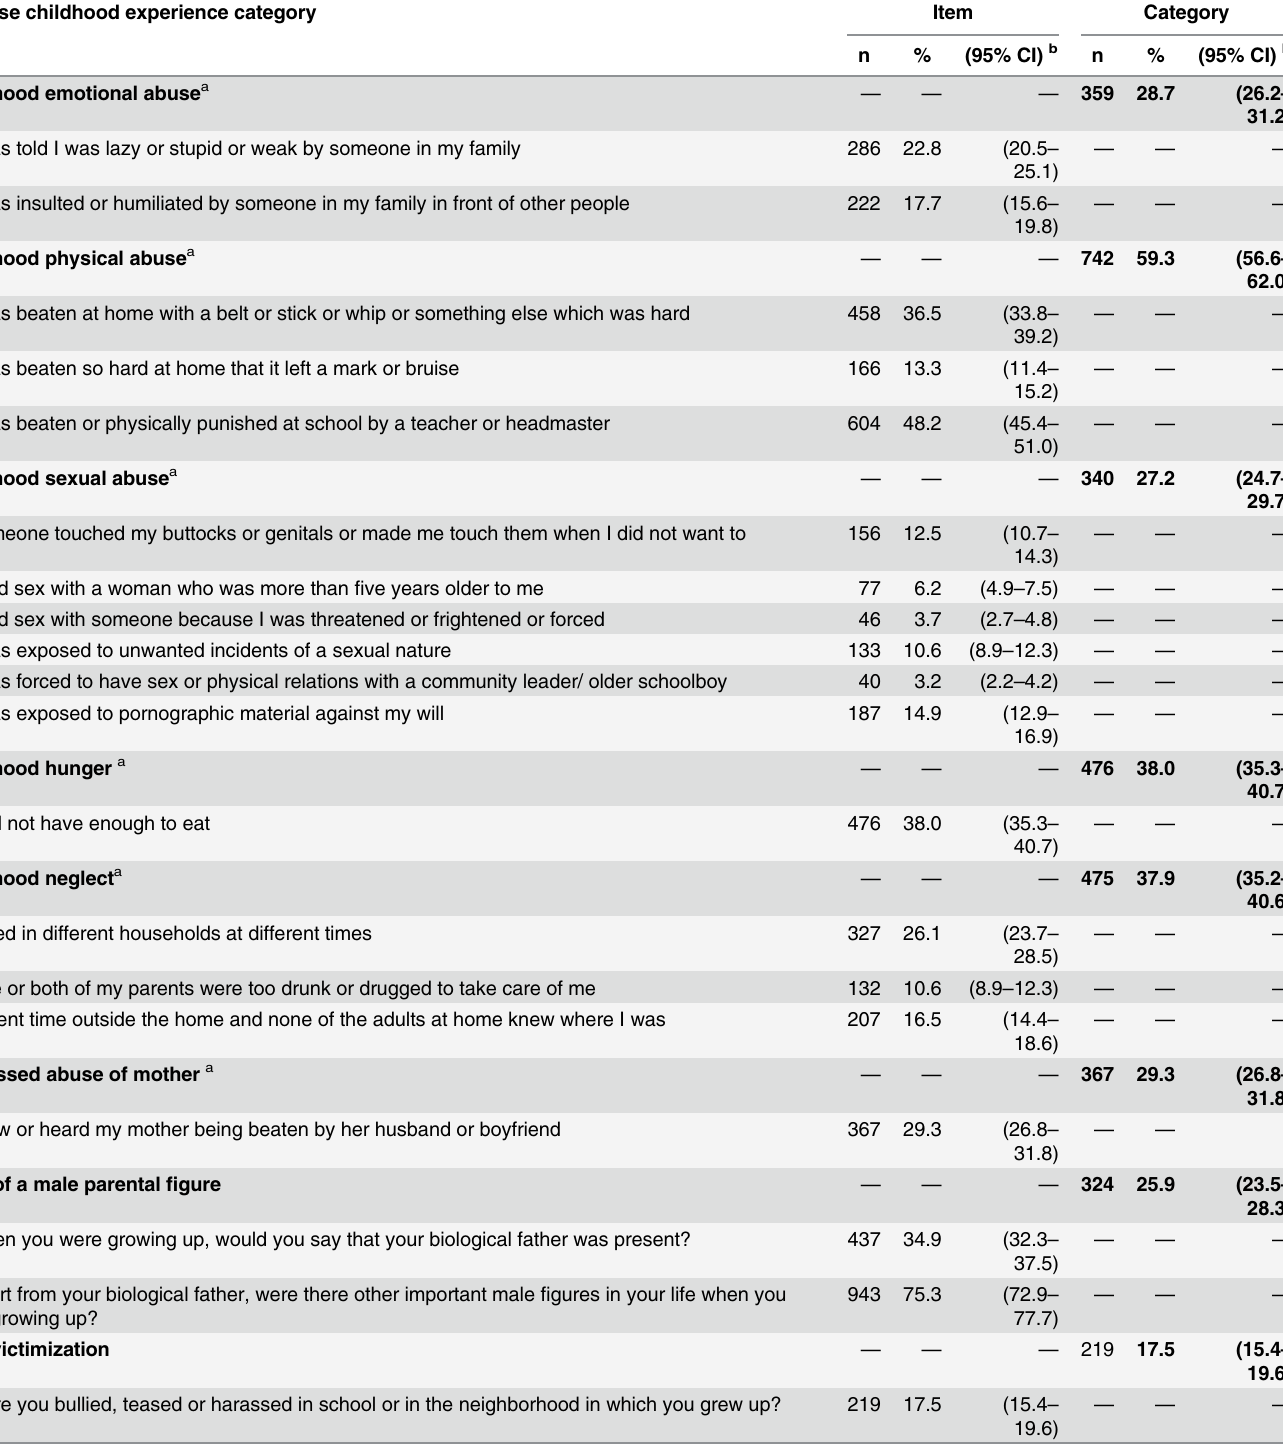
Table 2. Adverse childhood experience (ACE) categories and item prevalence among ever-partnered Sri Lankan men (n = 1252), UN Multi-Country Study on Men and Violence in Asia and the Pacific, Sri Lanka, 2011 – 2012. Adverse childhood experience